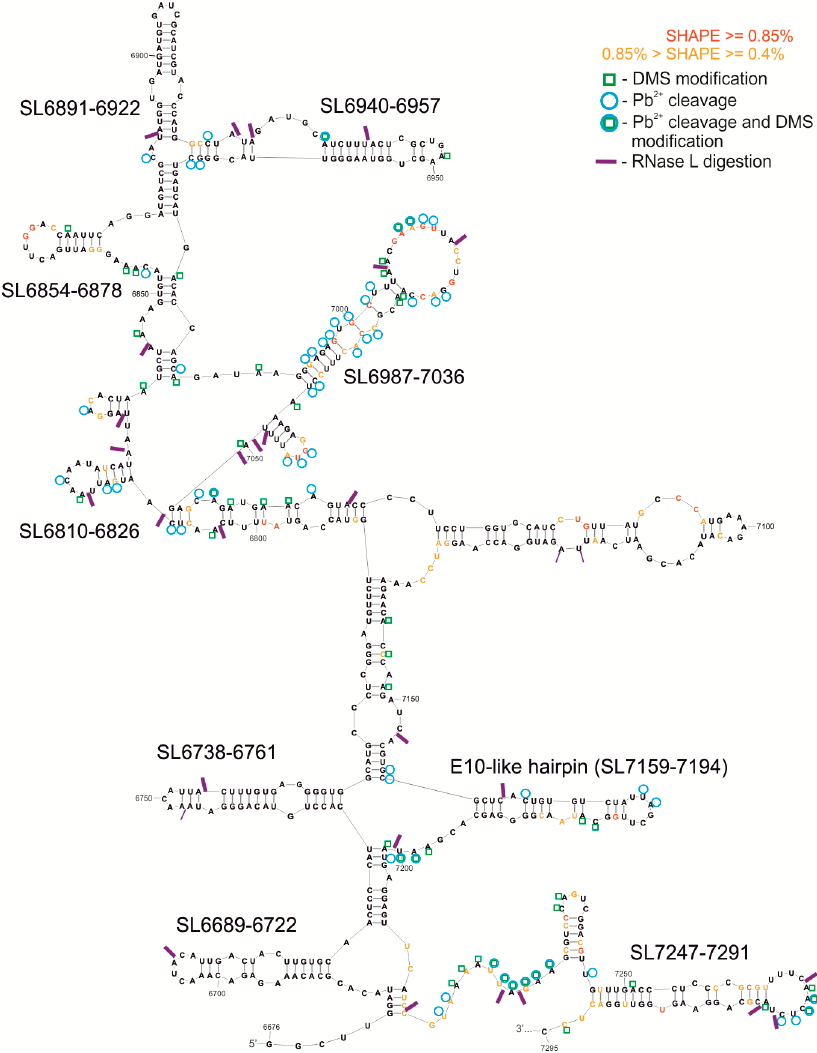
Figure 3. Secondary structure model of F10 RNA, without the last 120 nt of the known pseudoknot. The free energy of the structure is − 286.4 kcal/mol. This model displays NMIA modification sites from the SHAPE reaction, DMS modification sites, RNase L digestion, and Pb 2+ cleavages, according to the key. In addition, the most interesting structural motifs are marked with their